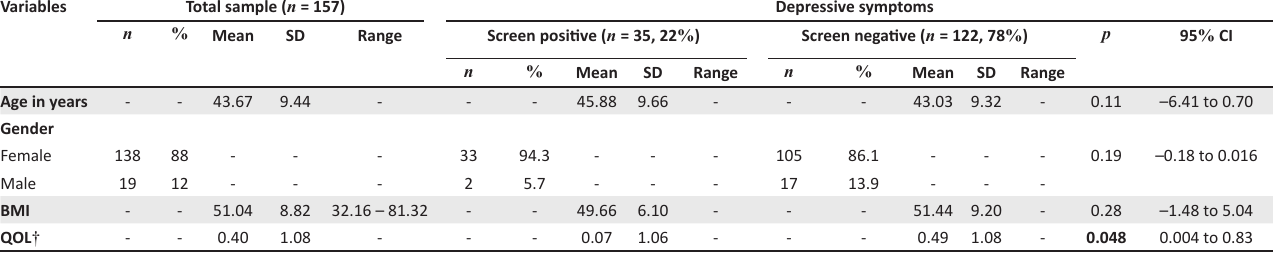
TABLE 1: Baseline demographic characteristics for participants who screened positive versus those who screened negative for depressive symptoms. Variables